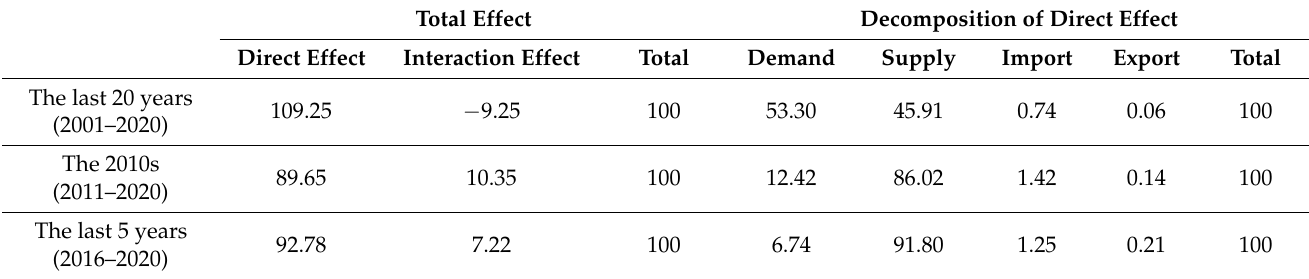
Table 8. Price fluctuation analysis results of